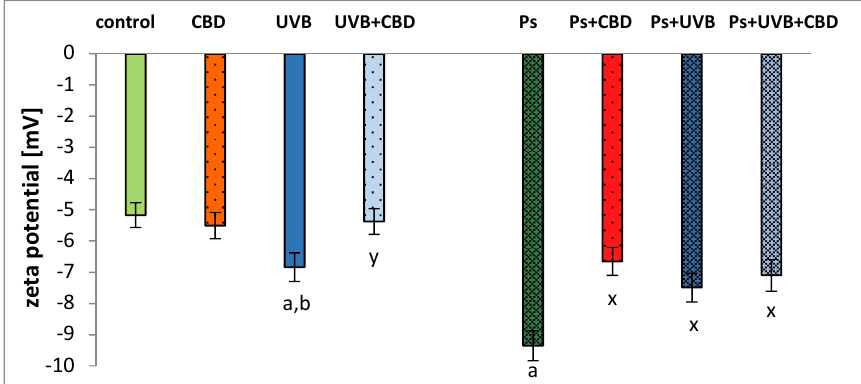
Figure 7. Zeta potential of keratinocytes isolated from the skin of healthy subjects (Control) and psoriatic patients (Ps). These cells were not treated and treated with CBD (4 μM) or/and UVB (60 mJ/cm 2 ). All samples were analyzed after 24 h of treatment. Mean values ± SD are presented with statistically significant differences: ( a ) vs. control group; ( b ) vs. CBD treated group; ( x ) vs. psoriasis group; ( y ) vs. UVB treated group, p < 0.05.